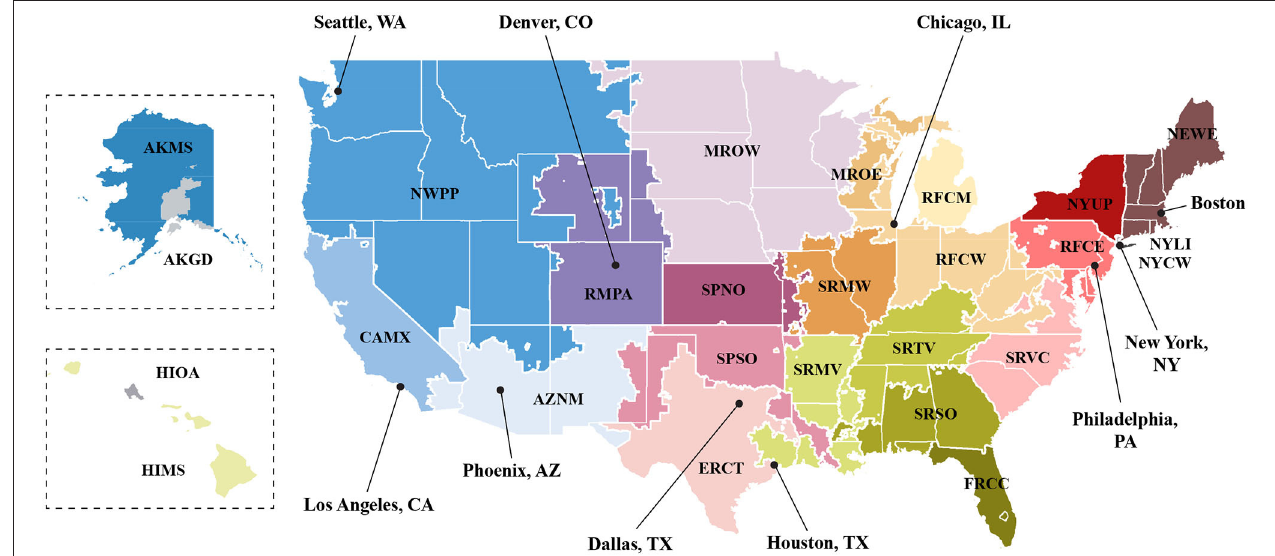
FIGURE 1 | Map of eGRID sub-regions with each of the 10 cities of interest